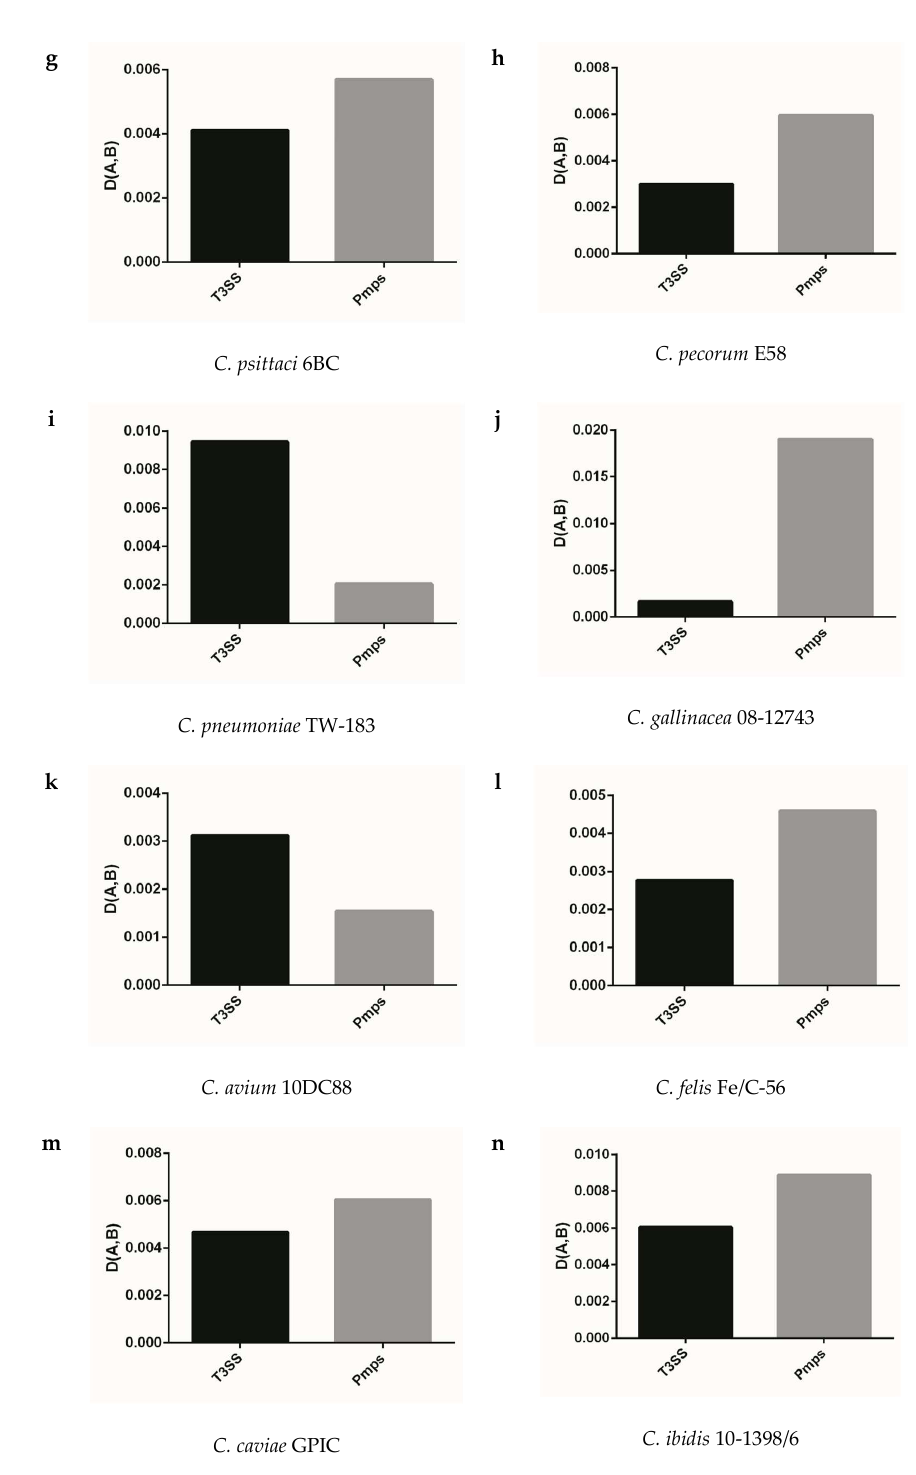
Figure 5. The adaptation of synonymous codon usage patterns between T3ss and Pmps gene families to the corresponding genome. ( a ) C. trachomatis L2/25567R, ( b ) C. trachomatis A-HAR-13, ( c ) C. trachomatis E/SW3, ( d ) C. suis MD56, ( e ) C. muridarum Nigg, ( f ) C. abortus S26/3, ( g ) C. psittaci 6BC, ( h ) C. pecorum E58, ( i ) C. pneumoniae TW-183, ( j ) C. gallinacea 08-12743, ( k ) C. avium 10DC88, (l) C. felis Fe/C-56, ( m ) C. caviae GPIC, ( n ) C. ibidis